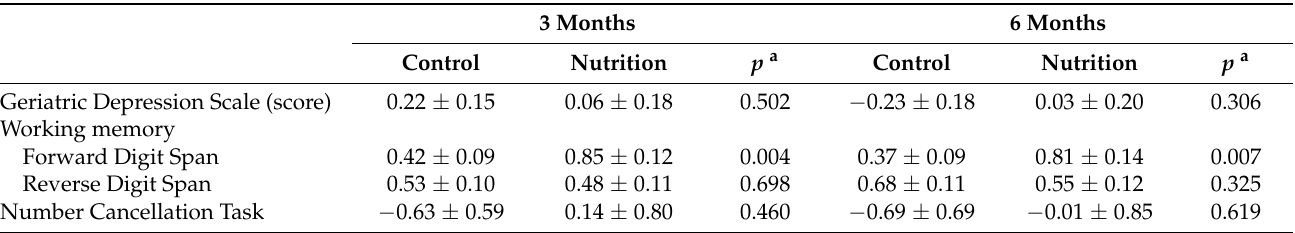
Table 5. Effect of nutrition education program on Geriatric Depression Scale and working memory 1